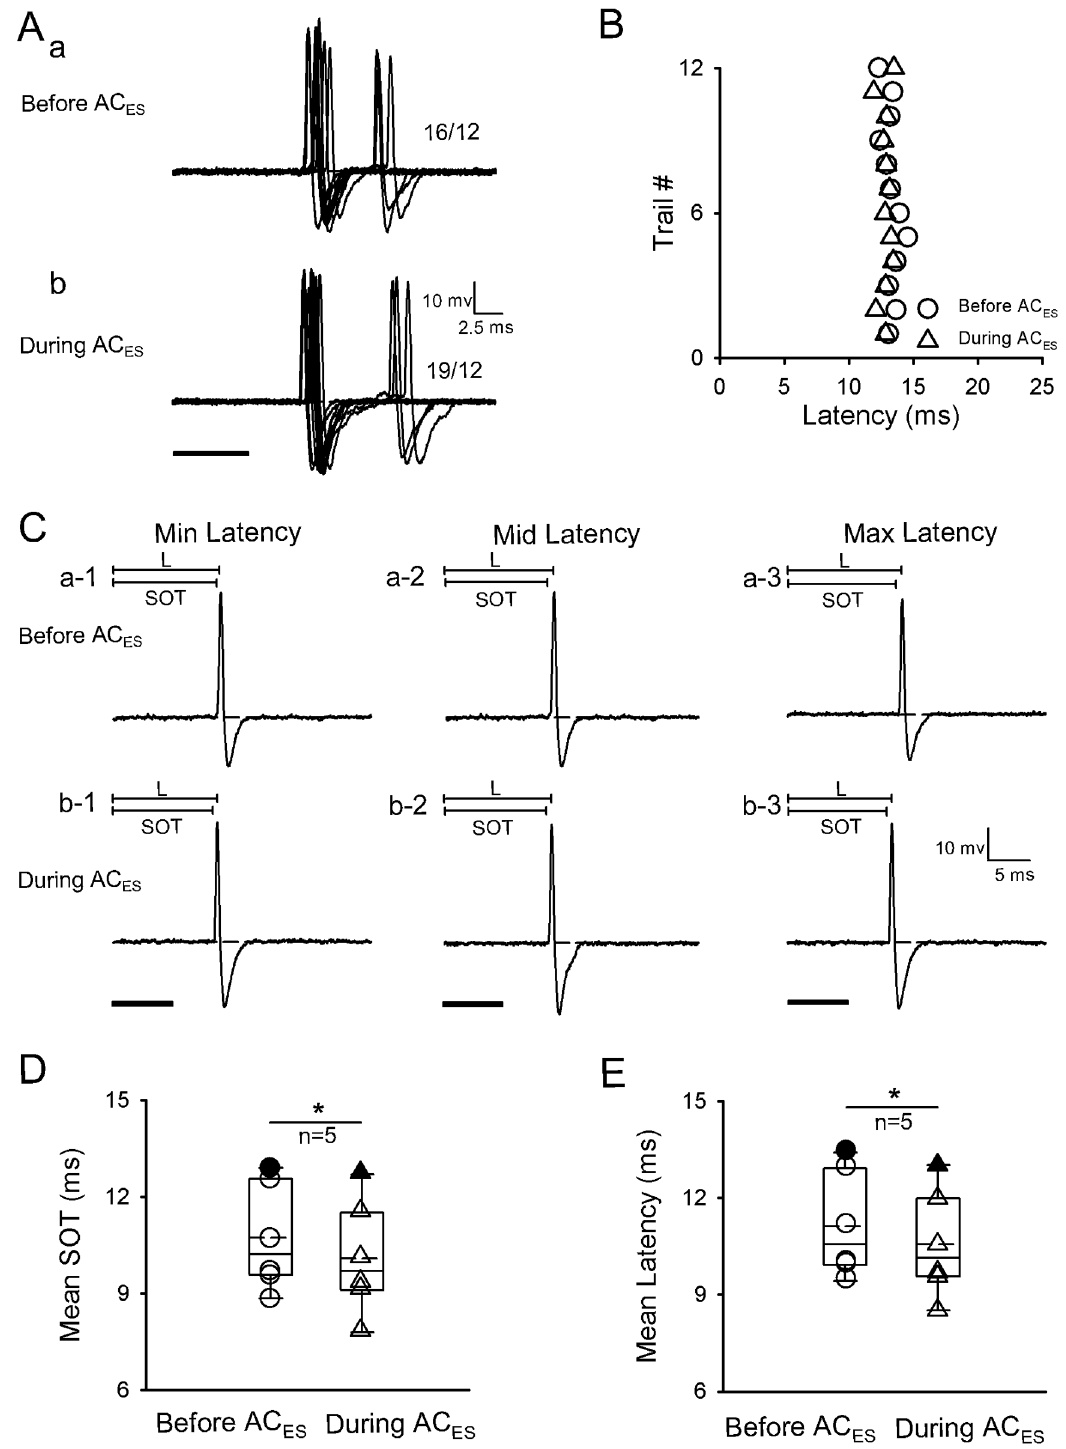
Fig 4. Representative facilitated IC neuron by AC ES showing its latency decreasing induced by SOT forward- shift. Original responsetraces obtainedby 12 repetitive pure tone stimulationconditions before (Aa) and during(Ab) AC ES . (B) Distributionof latency values calculatedaccordingto Aa and Ab before (unfilledcircle) and during(unfilled triangle)AC ES . (C) Three representative (i.e., minimum (a-1, b-1), middle (a-2, b-2), and maximum (c-1, c-2)) latencies selectedfrom Aa and Ab before (Ca-1–a-3)and during(Cb-1–b-3)AC ES . (D) Comparison of mean SOTs for this type of